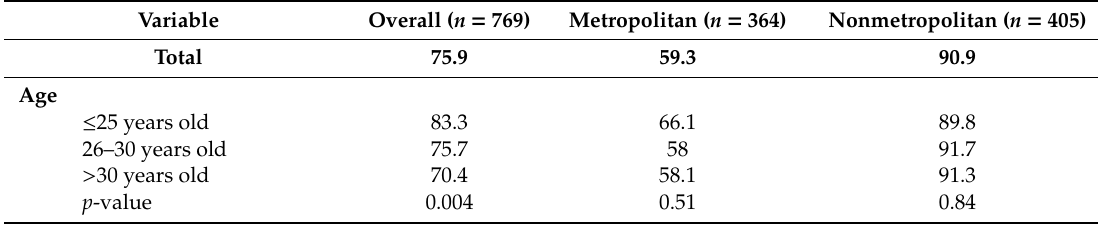
Table 2. Demographic di ff erences and the intention to vaccinate against HPV